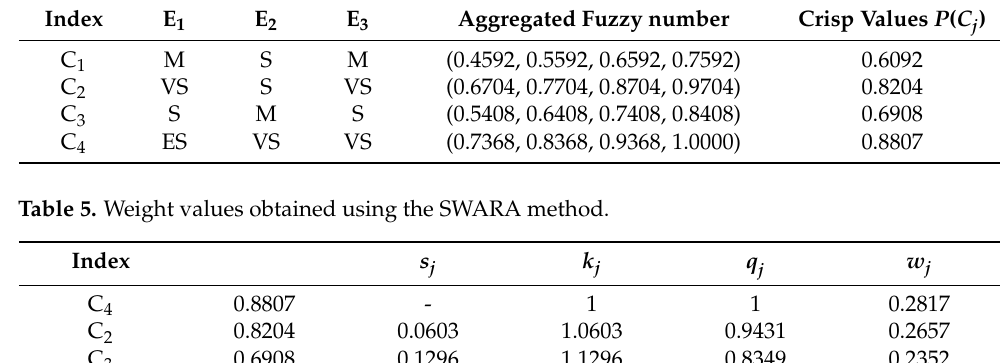
Table 5, the weight of the evaluation index can be obtained as follows: